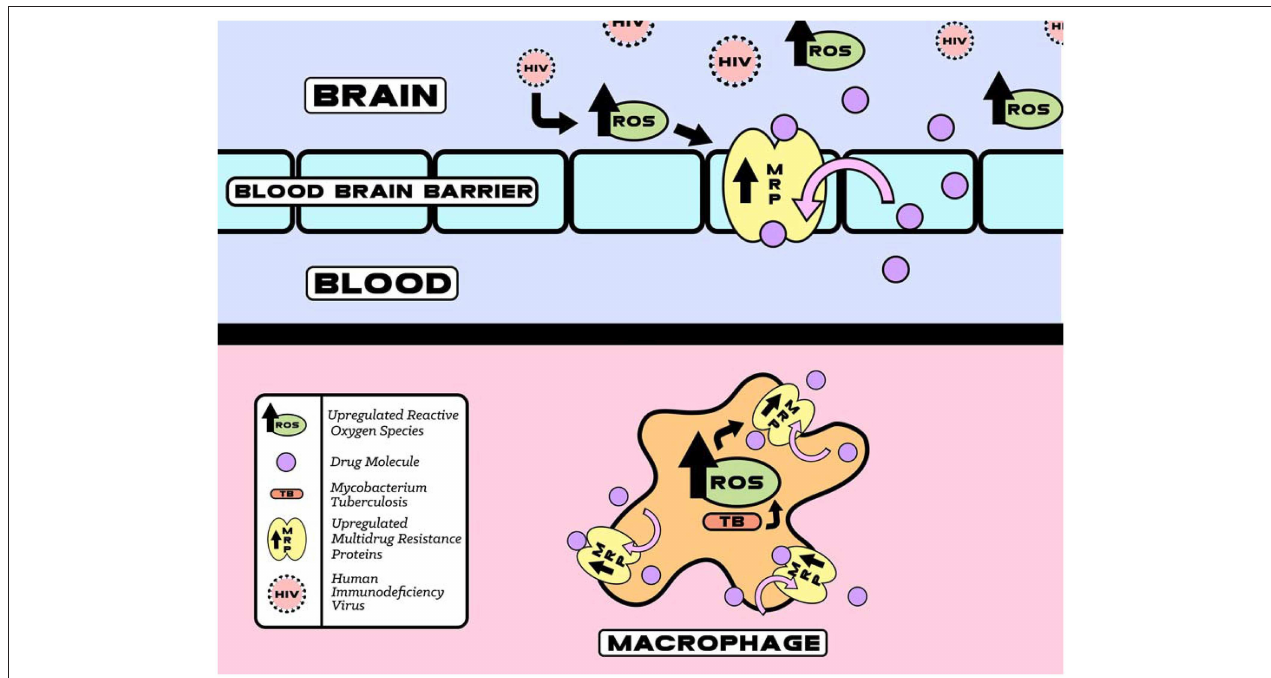
FIGURE 2 | HIV and TB induced upregulation of reactive oxygen species (ROS) that increases MRP function. The increase in MRP mediated HIV and TB drugs efflux eventually decreases therapeutic